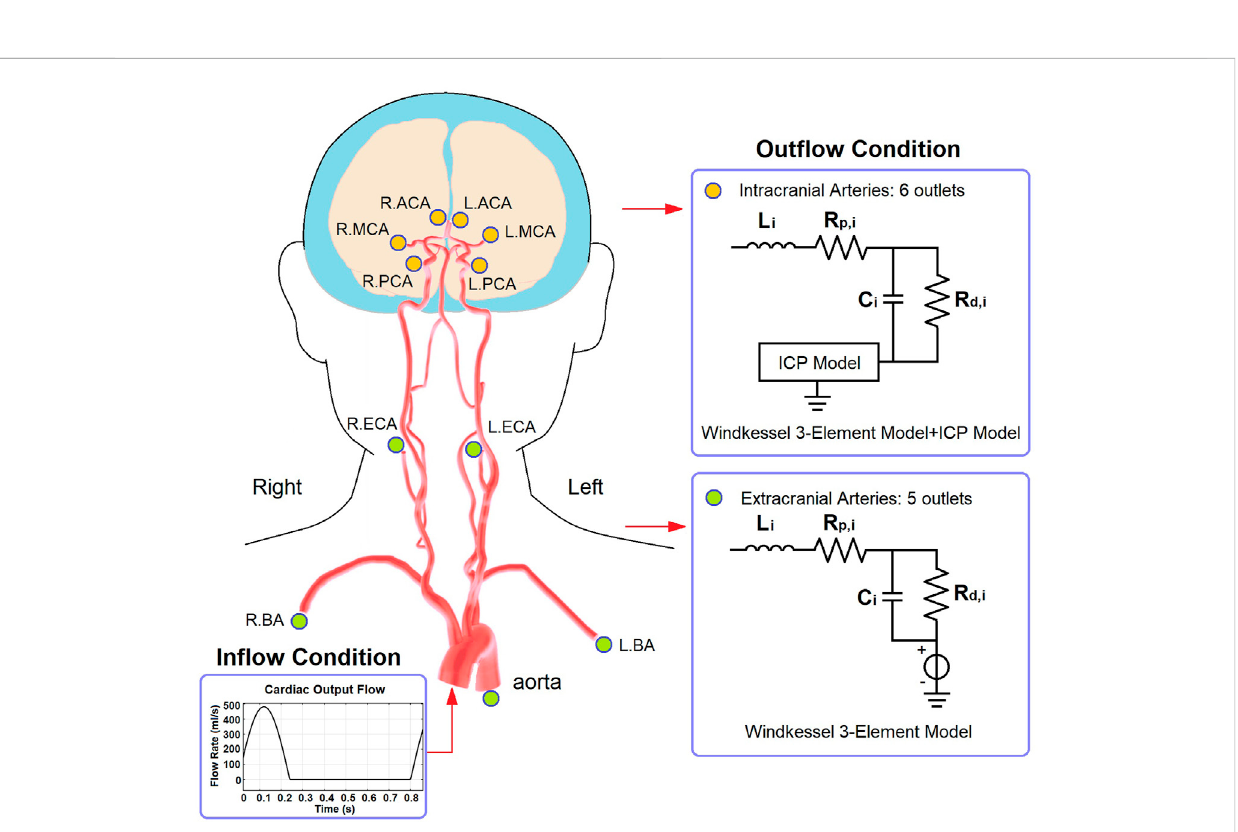
FIGURE 2 The structure of cardiocerebral artery network and the boundary conditions. The illustration of artery structure is adapted from Figure 2 of (Kang et al., 2021).